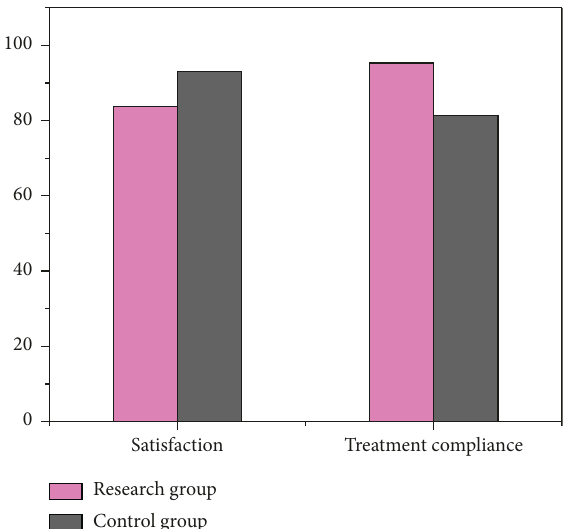
Figure 6: Comparison of treatment satisfaction and cooperation between the two groups.